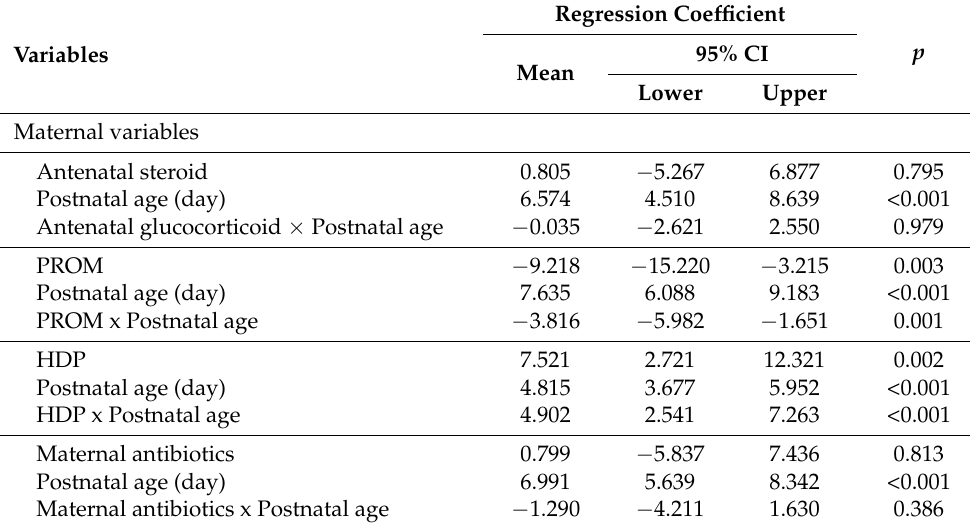
Table 3. Dependence of alpha 1 acid glycoprotein levels on postnatal age, clinical variables, and their